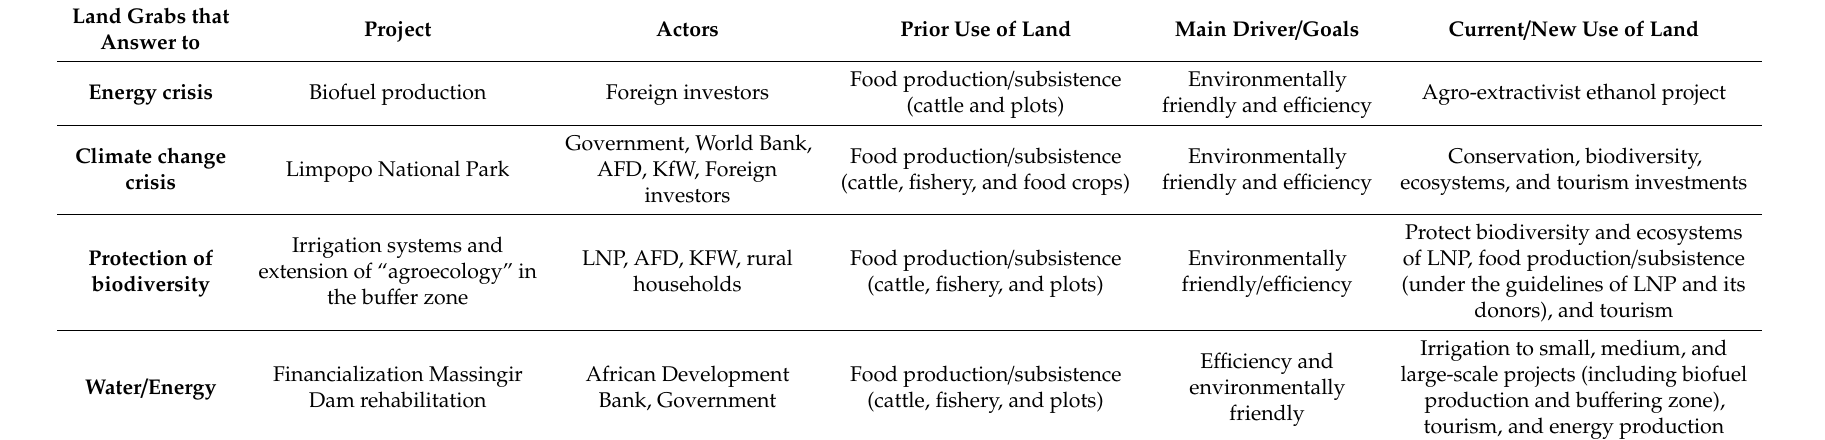
Table 1. Massingir District’s resource grabbing, synergies, and